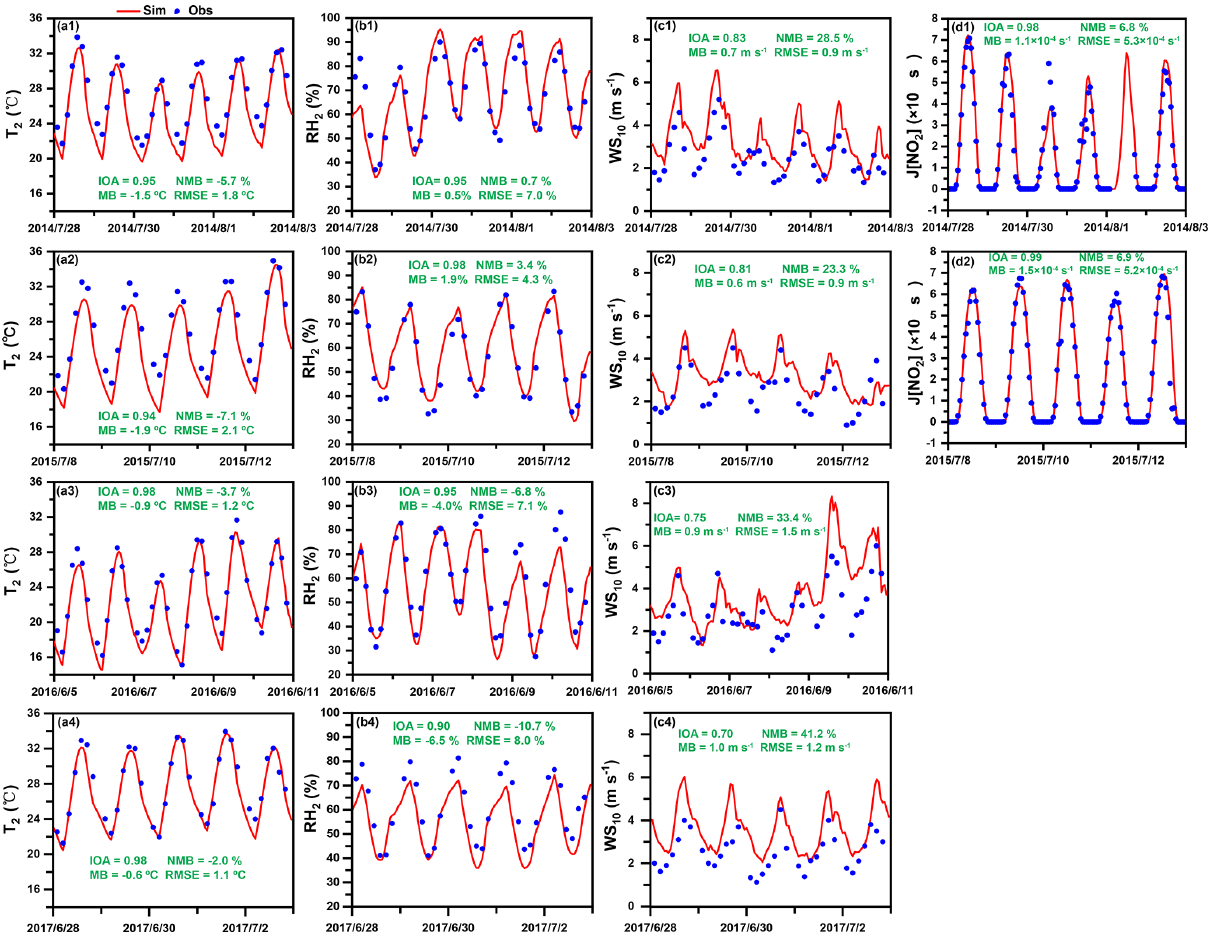
Figure 3. Time series of 3h observed (blue dots) and hourly simulated (red lines) (a) 2m temperature ( T 2 ), (b) 2m relative humidity (RH 2 ), and (c) wind speed at 10m (WS 10 ), averaged over 10 meteorological observation stations, and the (d) surface photolysis rate of NO 2 ( J [ NO 2 ] ) during 28 July to 3 August 2014 (Episode1; a1 – d1 ), 8–13 July 2015 (Episode2; a2 – d2 ), 5–11 June 2016 (Episode3; a3 – c3 ), and 28 June to 3 July 2017 (Episode4; a4 – c4 ). The calculated index of agreement (IOA), mean bias (MB), normalized mean bias (NMB), and root mean square error (RMSE) are also